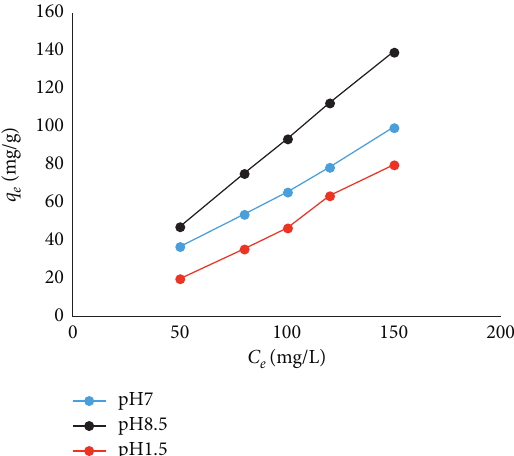
Figure 6: Effect of initial MB concentration on MB removal via MSN-Cys at different pH values (25 ° C for 200min, 150rpm).